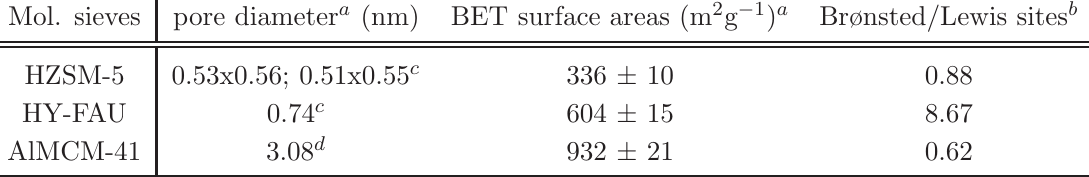
Table 1 Characterizing data of the molecular